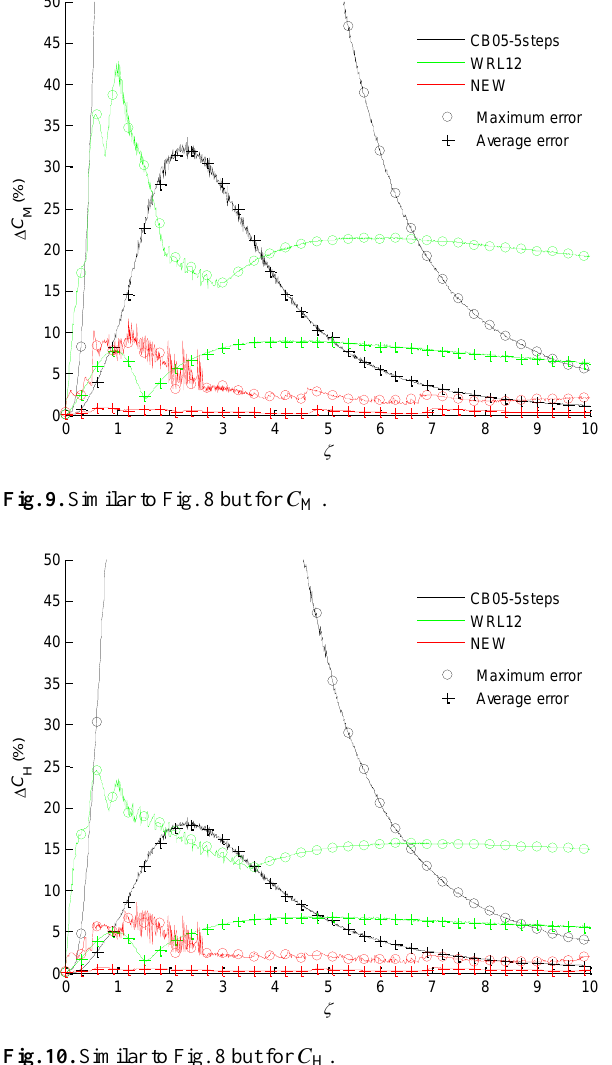
Fig. 10. Similar to Fig. 8 but for C H . Figure 10.Similar toFigure 8 but for C H . 2